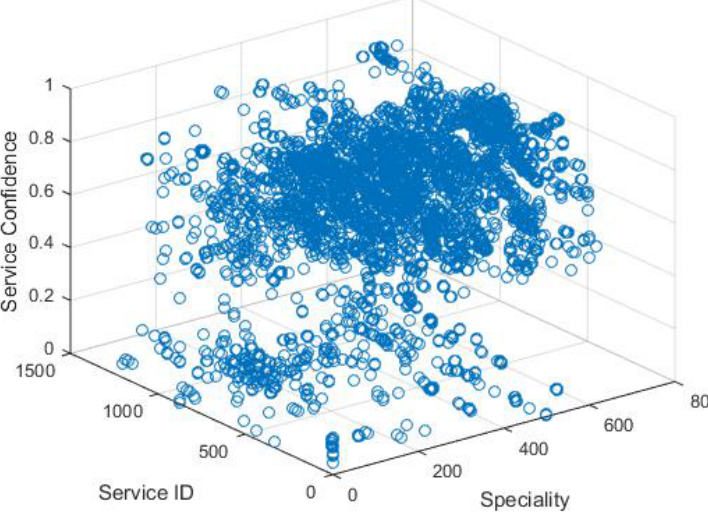
Figure 13. Scatter plot for all services confidence for all